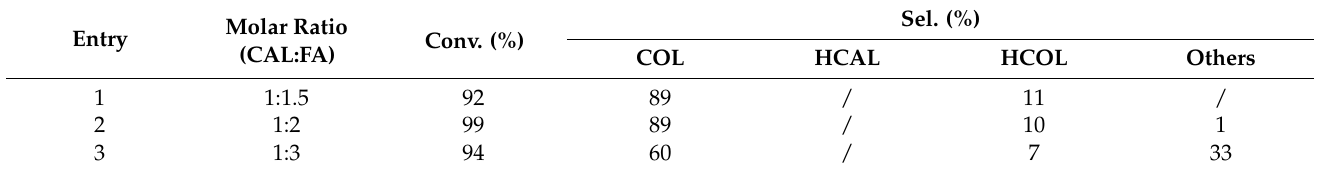
Table 3. Effect of CAL:FA molar ratio on the hydrogenation of CAL to